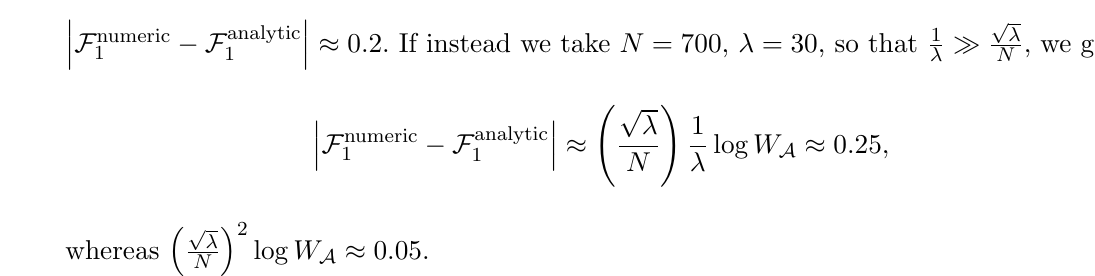
Figure 4 . Linear dependence of ( k ) on λ : each line corresponds to a particular value of k in the F 1 range 100 < k < 300, with N = 400. The dashed rays are included simply as visual aids. For large enough λ we see precisely the linear behavior obtained in